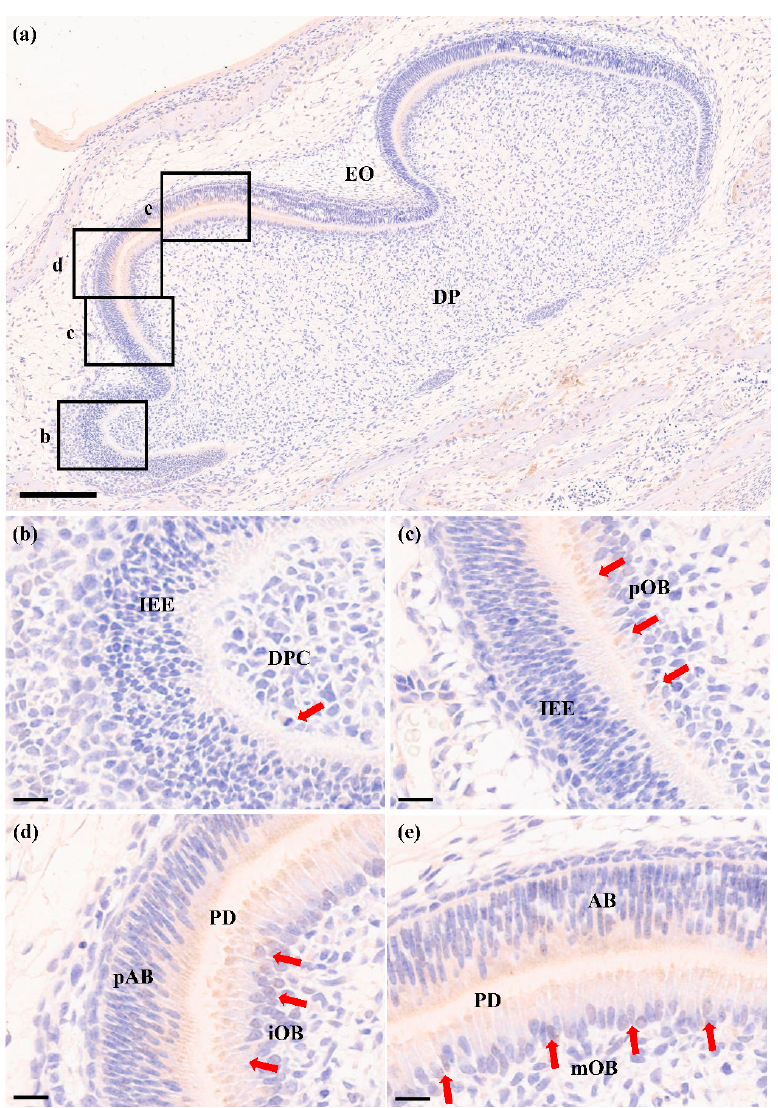
Figure 3. The expression pattern of retinoid acid receptor-related orphan receptor α (ROR α ) during odontoblastic differentiation in vivo. ( a ) Immunochemistry analysis showed the changes in expression levels of ROR α during odontoblastic differentiation in the first lower molar of 1-day postnatal Sprague-Dawley rats; ( b ) ROR α was weakly expressed in undifferentiated DPCs; ( c ) The expression of ROR α began to increase in preodontoblasts; ROR α was strongly expressed in immature odontoblasts ( d ), and the intense expression of ROR α was maintained in mature odontoblasts ( e ). Red arrows mark ROR α -positive cells. AB, ameloblasts; DP, dental papilla; DPC, dental papilla cells; EO, enamel organ; IEE, inner enamel epithelium; iOB, immature odontoblasts; mOB, mature odontoblasts; pAB, preameloblasts; PD, predentin; pOB, preodontoblasts. Scale bar: ( a ) 200 µ m; ( b – e ) 20 µ To determine the functional role of ROR α in the regulation of odontoblastic differentiation, we overexpressed ROR α in rDPCs by transfecting them with pcDNA3.1- ROR α . Cells transfected with pcDNA3.1-NC were used as the negative control. The efficiency of ROR α overexpression was confirmed by qRT–PCR and western blotting,